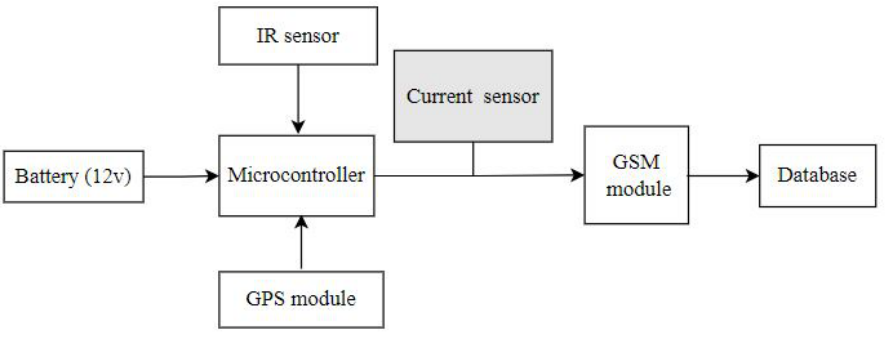
Figure 4. Current acquisition